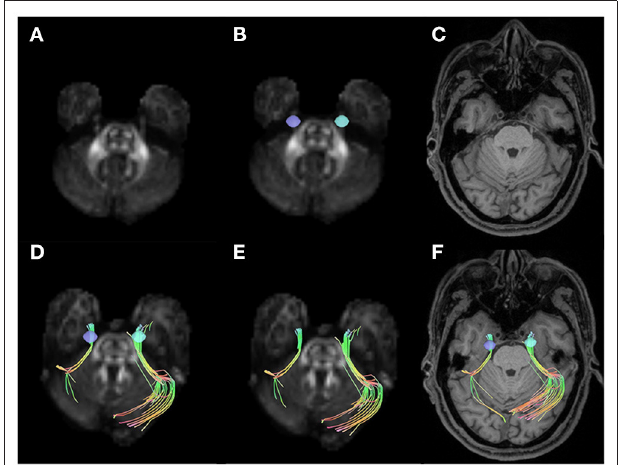
FIGURE 1 | Examples of volumes of interest, trigeminal nerve tracking, and trigeminal nerve reconstruction. (A) Shows the quantitative anisotropy